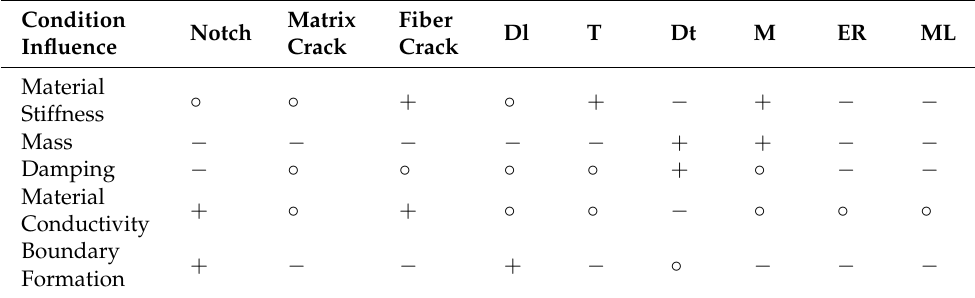
Table 3. Influence of environmental conditions on local properties of composite structures. ( + ) strong, ( ◦ ) average, and ( − ) weak influence. (Dl) Delamination, (T) Temperature, (Dt) Dirt, (M) Moisture, (ER) Electromagnetic Radiation, and (ML) Mechanical Load.